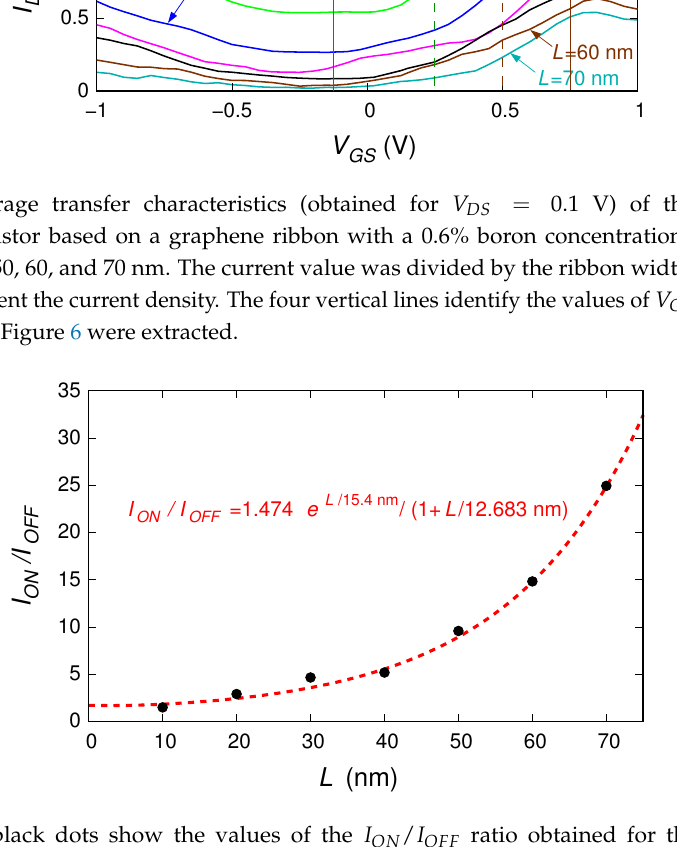
Figure 5. The black dots show the values of the I ON / I OFF ratio obtained for the double-gate field-effect-transistor based on the graphene ribbon with a 0.6% boron concentration, for the seven considered ribbon lengths. The red dashed line represents the extrapolated analytical